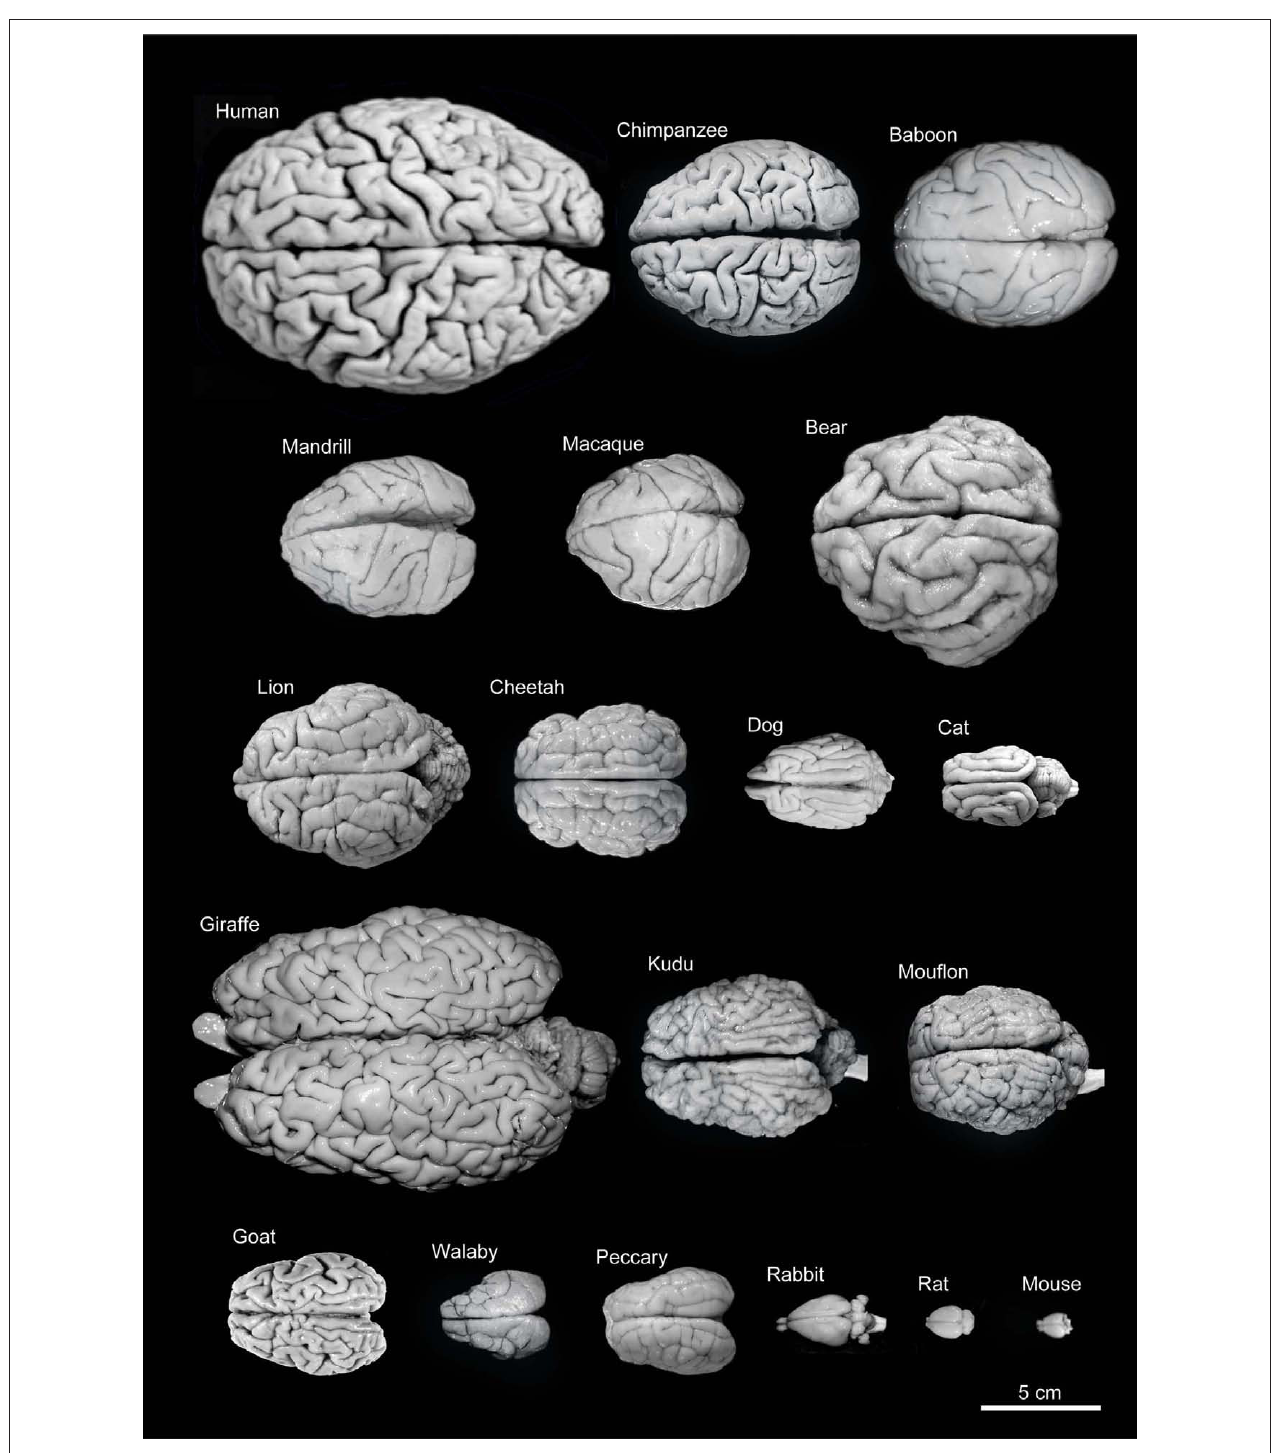
Figure 7 | Variability of brain size and external topography. Photographs and weights of the brains of different species. Primates: human ( Homo sapiens , 1.176 kg), chimpanzee ( Pan troglodytes , 273 g), baboon ( Papio cynocephalus , 151 g), mandrill ( Mandrillus sphinx , 123 g), macaque ( Macaca tonkeana , 110 g). Carnivores: bear ( Ursus arctos , 289 g), lion ( Panthera leo , 165 g), cheetah ( Acinonyx jubatus , 119 g), dog ( Canis familiaris , 95 g), cat ( Felis catus , 32 g). Artiodactyls: giraffe ( Giraffa camelopardalis , 700 g),